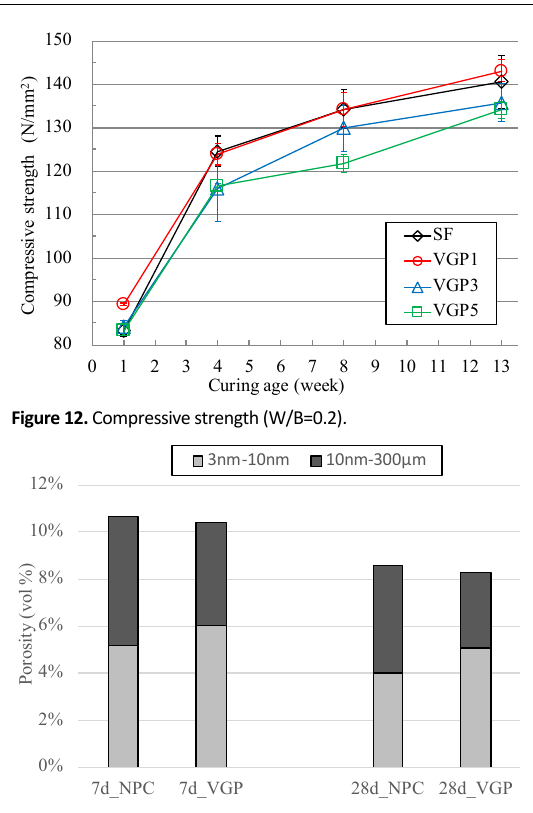
Figure 13. Porosity calculated from MIP date.